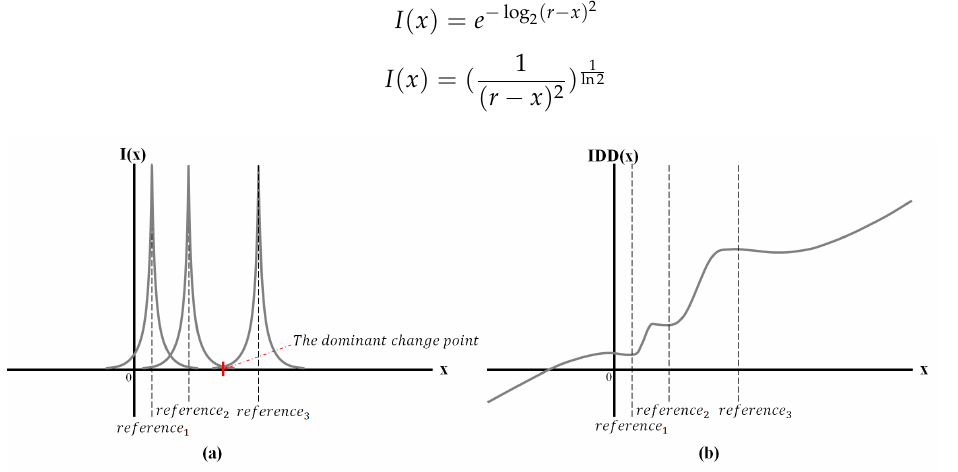
Figure 3. ( a ) Influence of the three reference points ( b ) Adjustment of sample points according to IDD